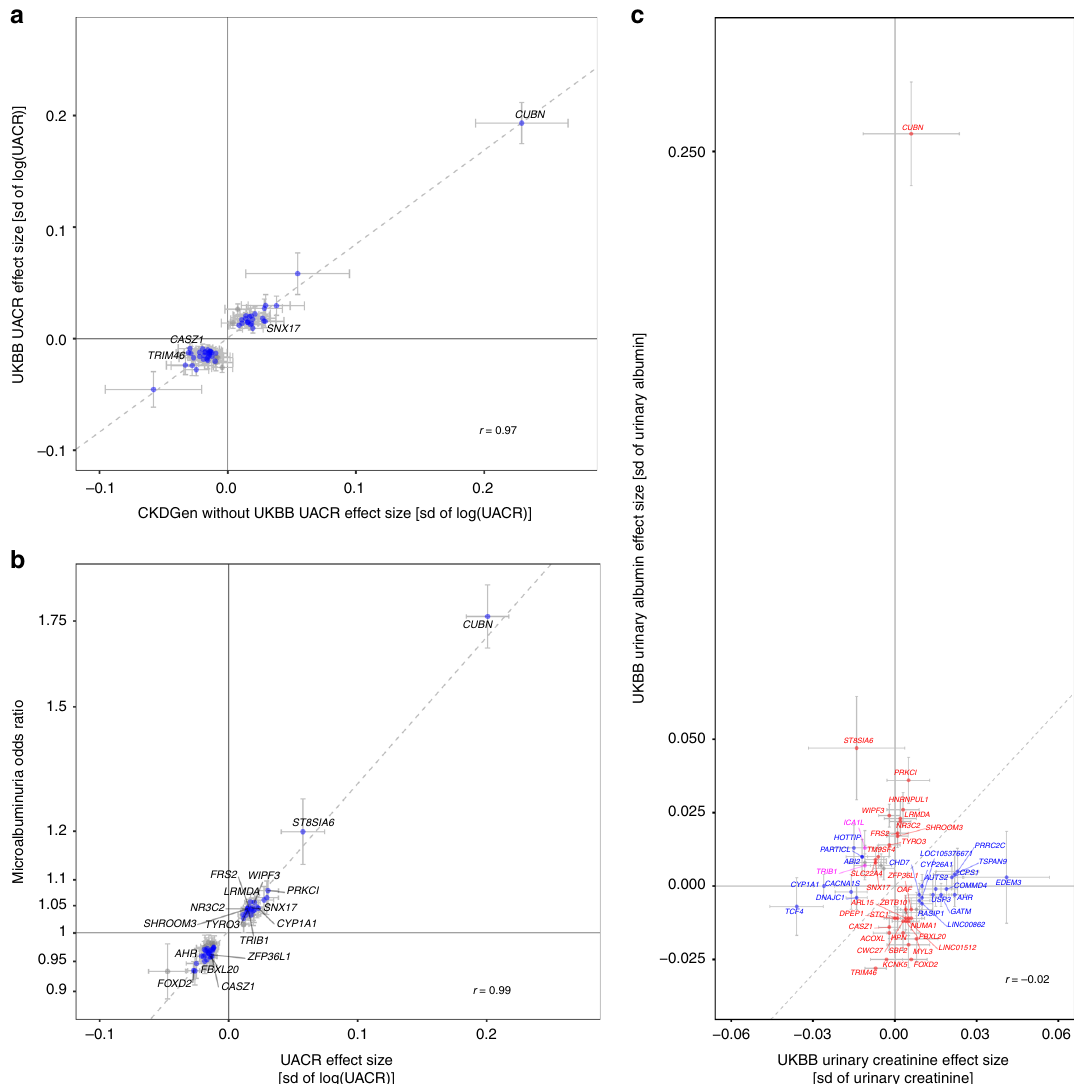
Fig. 2 Internal concordance of the urinary albumin-to-creatinine ratio (UACR) results, and association with microalbuminuria, urinary creatinine and albumin. a Comparison of effect estimates of the 59 genome-wide signi fi cant trans-ethnic UACR index SNPs in the UKBB ( x -axis) and in the CKDGen cohorts without UKBB ( y -axis). Blue dots indicate nominal signi fi cance ( p < 0.05) in the CKDGen cohorts without UKBB, and loci at genome-wide signi fi cance ( p < 5 × 10 − 8 ) in that meta-analysis are labeled with the closest gene. b Comparison of effect estimates of the 59 trans-ethnic UACR index SNPs ( x -axis) with their corresponding estimate from the GWAS of microalbuminuria (MA; y -axis). Blue dots indicate signi fi cance in the MA results after multiple testing correction ( p < 0.05/59 = 8.5 × 10 − 4 ), and loci that achieved genome-wide signi fi cance ( p < 5 × 10 − 8 ) for MA are labeled. In both panels, the dashed line represents the line of best fi t through the effect estimates. c Comparison of effect estimates of the 59 genome-wide signi fi cant trans-ethnic UACR index SNPs for their effect on urinary creatinine ( x -axis) and urinary albumin levels ( y -axis) in the UKBB sample. Blue, red, and purple color indicate signi fi cant associations after multiple testing correction ( p < 0.05/59 = 8.5 × 10 − 4 ) with urinary creatinine, urinary albumin, and both, respectively. Signi fi cant associations are labeled with the closest gene name. The dashed line represents the median y = x . In all panels, error bars indicate 95% con fi dence intervals (CIs), and the Pearson correlation coef fi cient r between the effect estimates is shown. The effect directions correspond to the effect allele of the trans-ethnic UACR meta-analysis